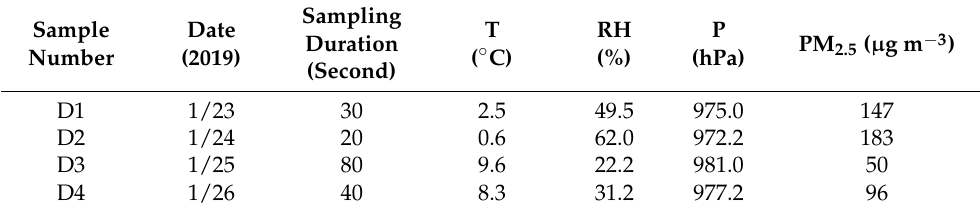
Table 1. Summary of sampling